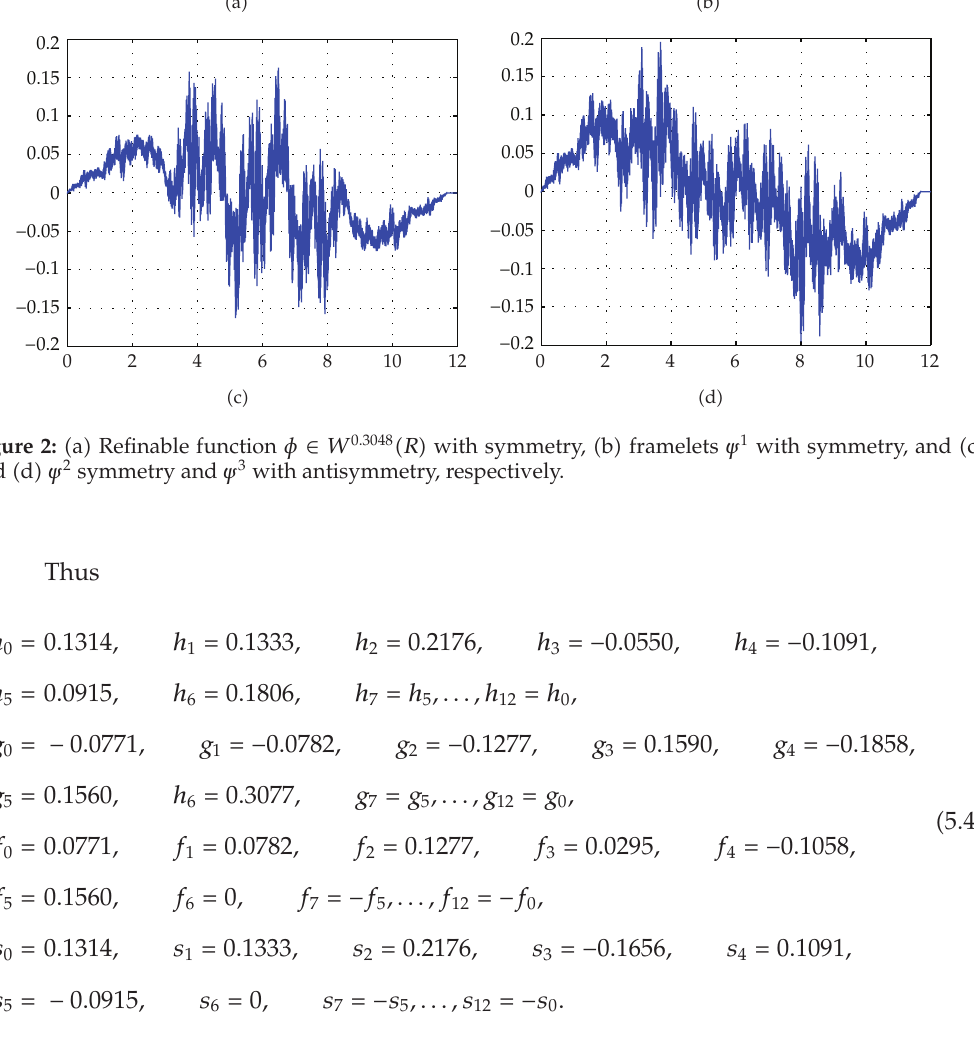
The resulting symmetric refinable function φ ∈ W 0 . 3048 (cid:6) R (cid:7) . See Figure 2 for the graphs of φ , ψ 1 , ψ 2 , and ψ 3